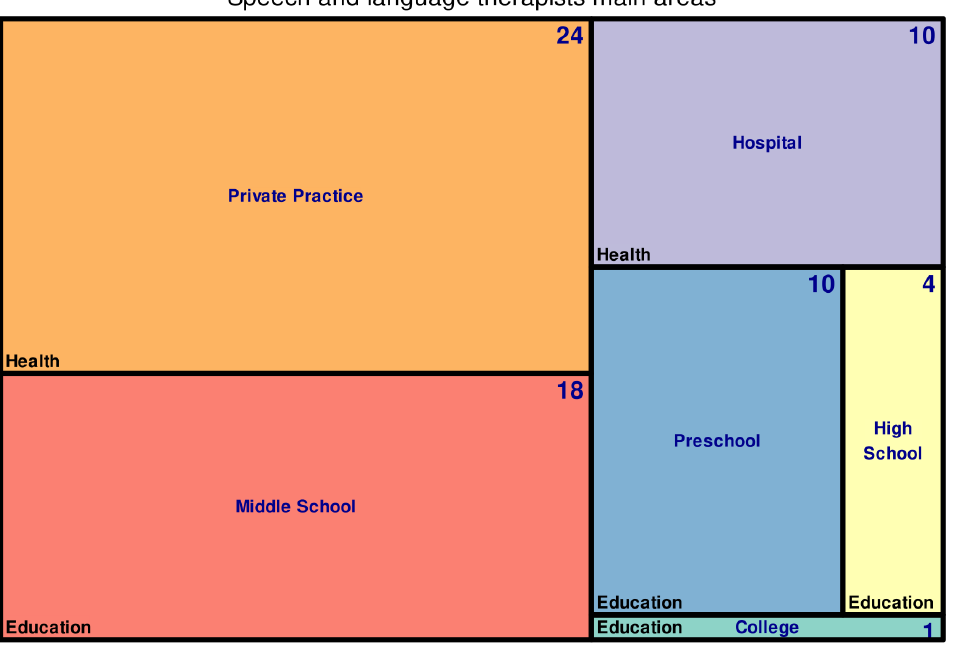
Figure 6. The main areas where these professionals carry out their activities.